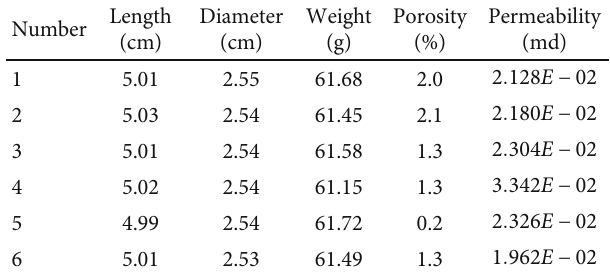
Table 1: Fundamental parameters of experimental